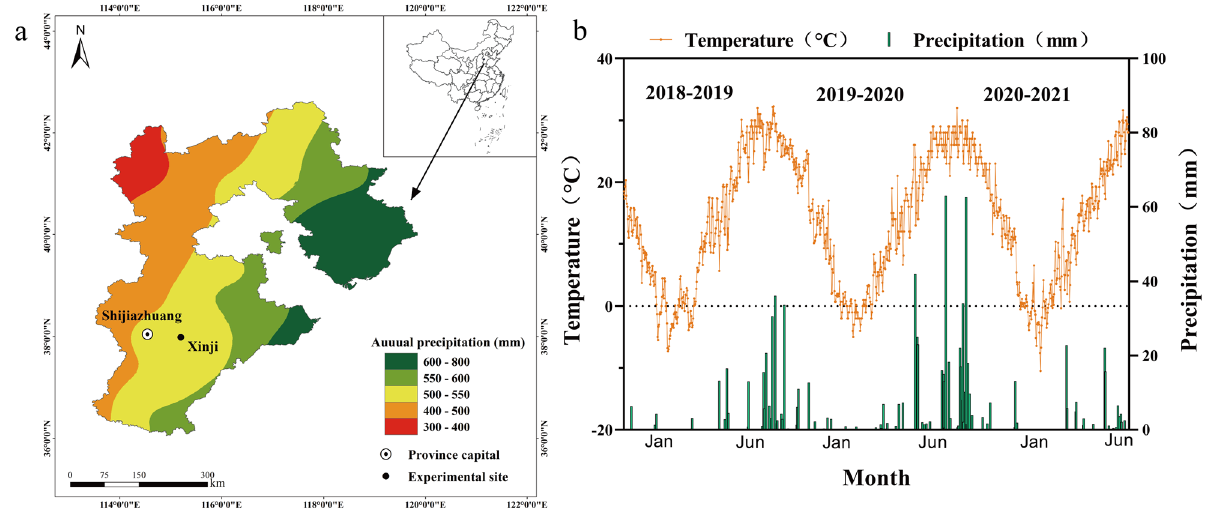
Figure 1. The location of experimental field ( a ) and as well as rainfall and temperature during the three growthing seasons ( b ).